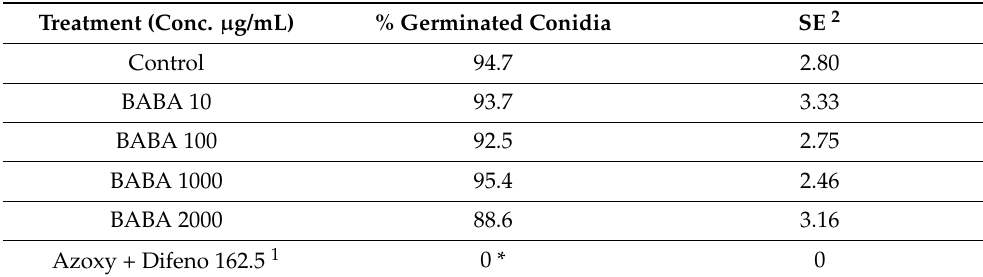
Table 1. Activity of BABA and the pre-mixture azoxystrobin plus difenoconazole on A. alternata f. sp. mali conidia germination.